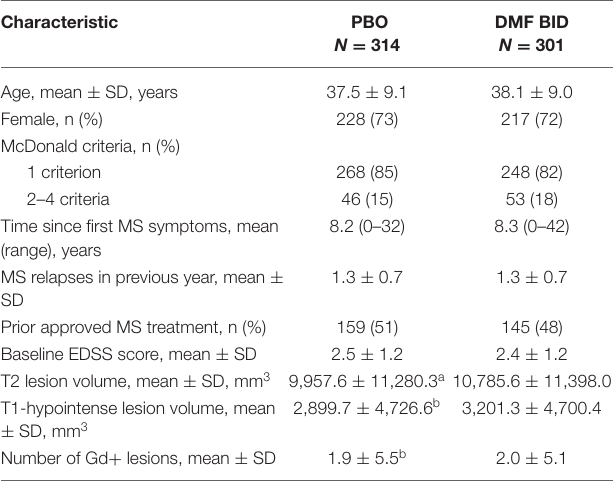
TABLE 1 | Key baseline demographics and disease